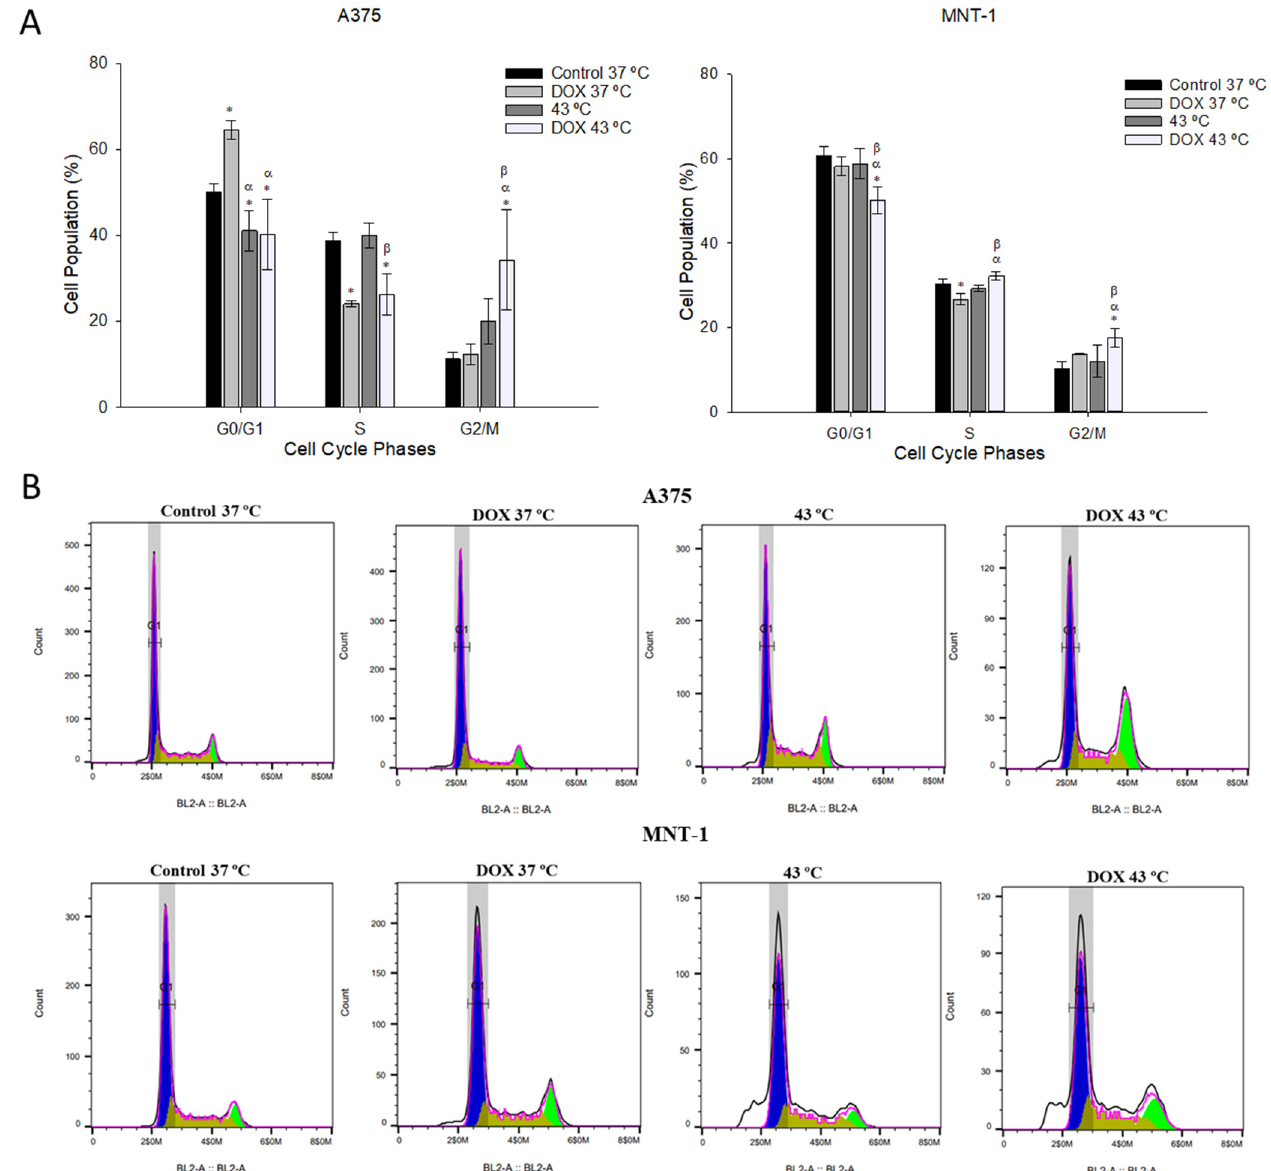
Figure 4. Effects of hyperthermia combined with DOX on cell cycle distribution. Cells were exposed to 43 °C for 30 min and 0.0125 μ M or 0.0179 μ M of DOX, in case of A375 or MNT-1 cells, respectively. ( A ) Cell cycle distribution (%) in A375 and MNT-1 cells; ( B ) histograms representative of cell distribution of A375 and MNT-1 cells. Data shown are mean values ± standard deviation of two independent experiments with two technical replicates each and each replicate with at least 5000 events. *—indicates statistical significance in comparison to the control 37 °C; α indicates statistical significance in comparison to the respective control of each condition at 37 °C; and β indicates statistical significance of the combined treatment in comparison to hyperthermia alone ( p < 0.05).